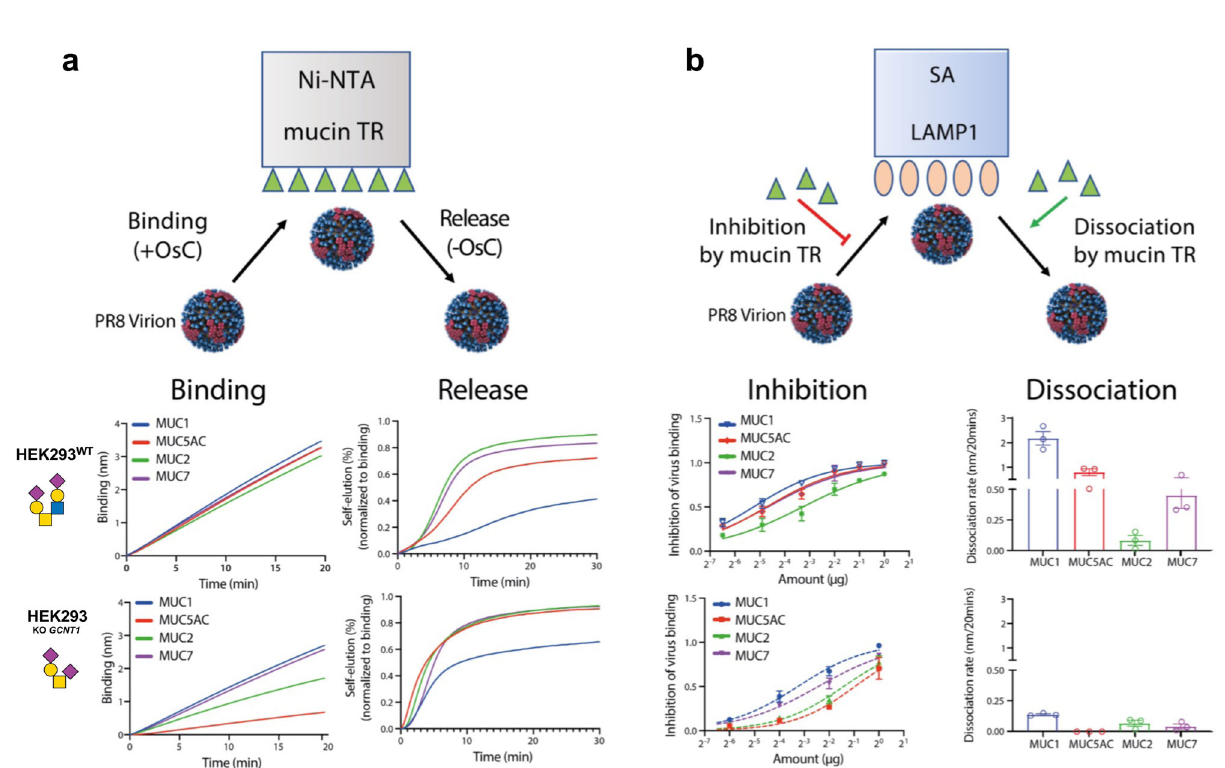
Fig. 7 Selective interactions of In fl uenza A virus (IAV) with mucin TR reporters. a Cartoon (top) illustrates assay design for IAV binding dynamics to sensor-immobilized mucin TR reporters (HA-mediated binding and NA-mediated release). Graphs show binding of PR8 IAV to probes loaded with MUC1, MUC2, MUC5AC, or MUC7 TR reporters produced in HEK293 WT or HEK293 KO GCNT1 in the presence of NA inhibitor (OsC), and self-elution of PR8 IAV from mucin TR reporters after removal of OsC is shown in time. b Cartoon (top) illustrates assay design for competition dynamics of soluble mucin TR reporters with IAV binding to sensor-immobilized LAMP1 (inhibition and dissociation) using biolayer interferometry analysis. Graphs show inhibition of PR8 binding to LAMP1-loaded probes by increasing concentrations of soluble mucin TR reporters produced in HEK293 WT or HEK293 KO GCNT1 as well as the ability of soluble mucin TR reporters to dissociate PR8 bound to LAMP1 from the probe. All graphs show representative data of three independent experiments as average values ± SEM. Source data are provided as a Source Data fi